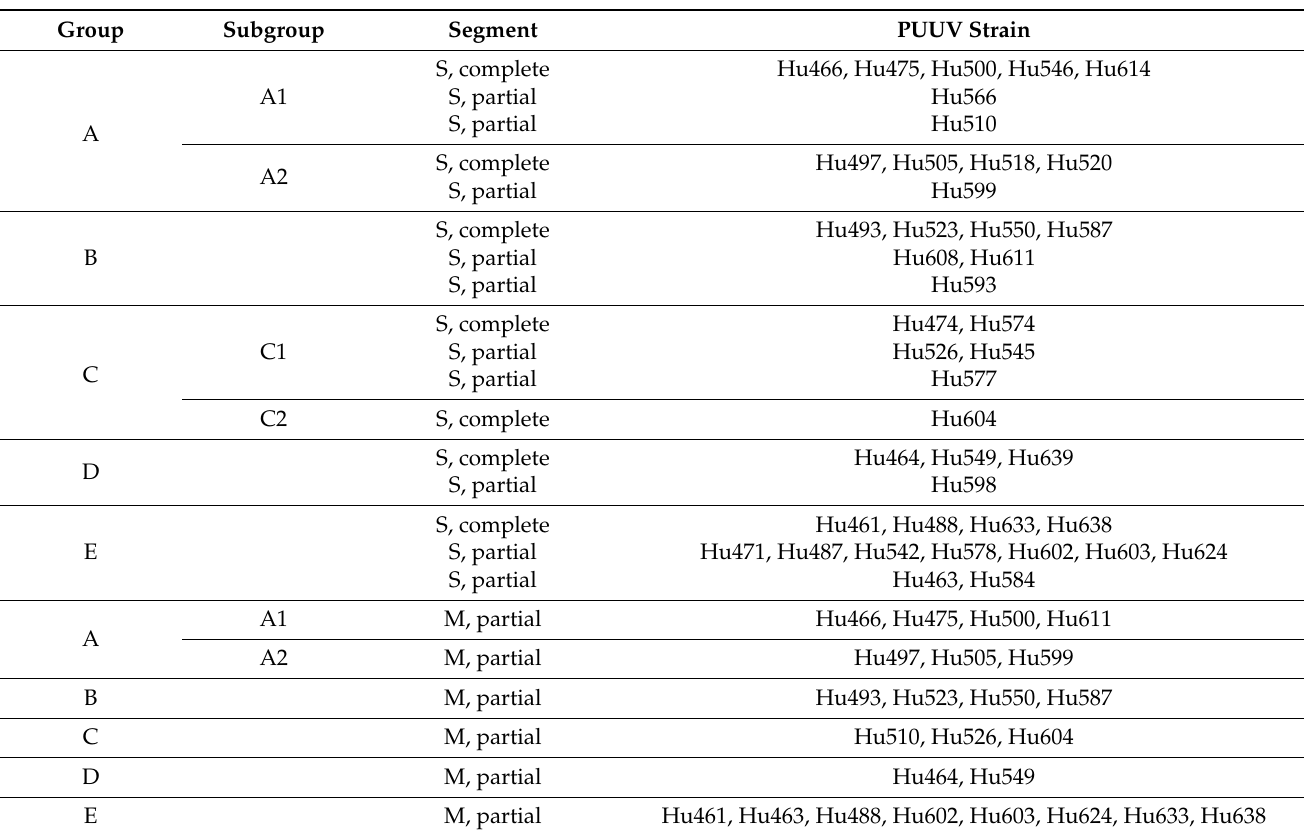
Table 1. Hemorrhagic fever with renal syndrome (HFRS) derived Puumala orthohantavirus (PUUV) strain groups based on nt sequence